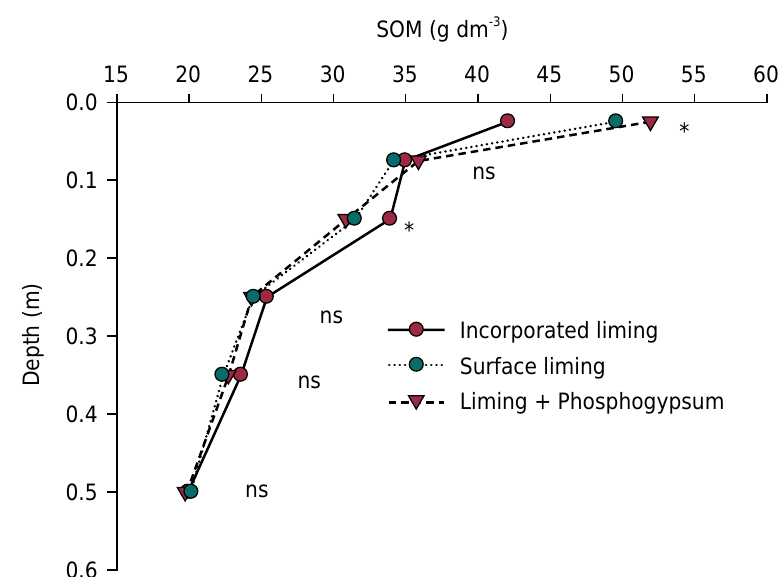
Figure 8. Soil organic matter (SOM) content in the soil profile as a function of liming method (surface application or incorporation) and combined surface treatment with lime and phosphogypsum (GY). Surface application, n = 16; lime incorporation, n = 16; lime + GY, n =